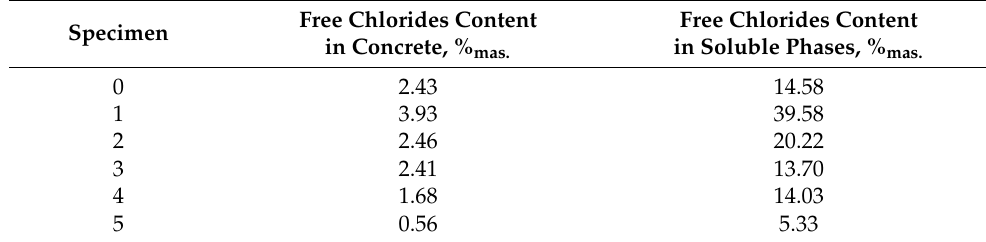
Table 6. The free chloride ions content in the concrete and in digested in HCl phase. Free Chlorides Content Specimen in Concrete, %